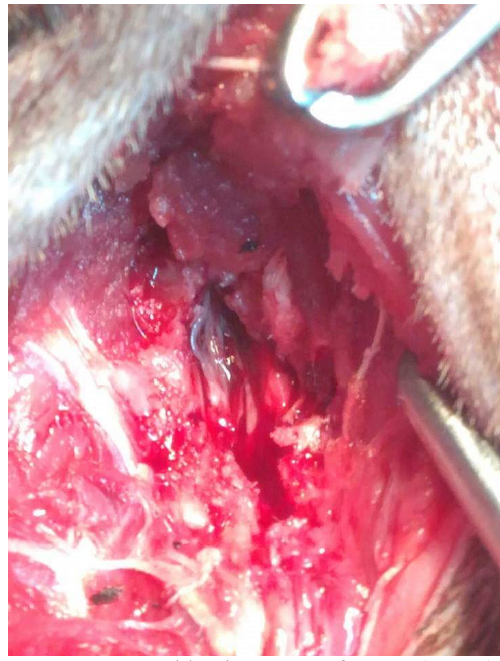
Figure 7. Dorsal laminectomy of S1-S3 (case